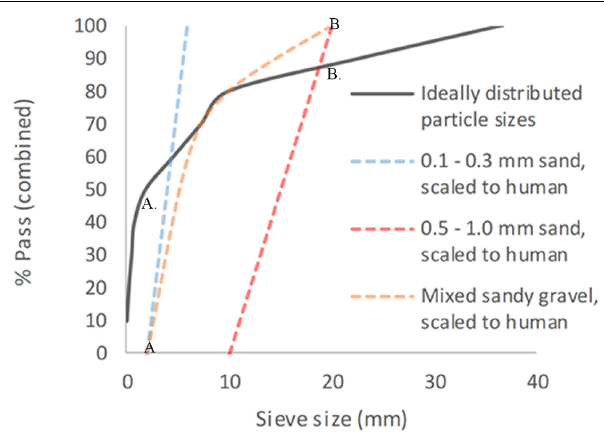
FIGURE 1 | Experimental sandy gravel sizes used, scaled to human values, shown alongside ideally distributed particle sizes. (A) = human median value. (B) = human 85th centile. (A) = lower limit of experimental sandy gravel range. (B) = upper limit of experimental sandy gravel range. % pass (combined) describes the percentage of total volume of sandy gravel passing a specific sieve size; sieve size (mm) relates to the diameter of each hole within the